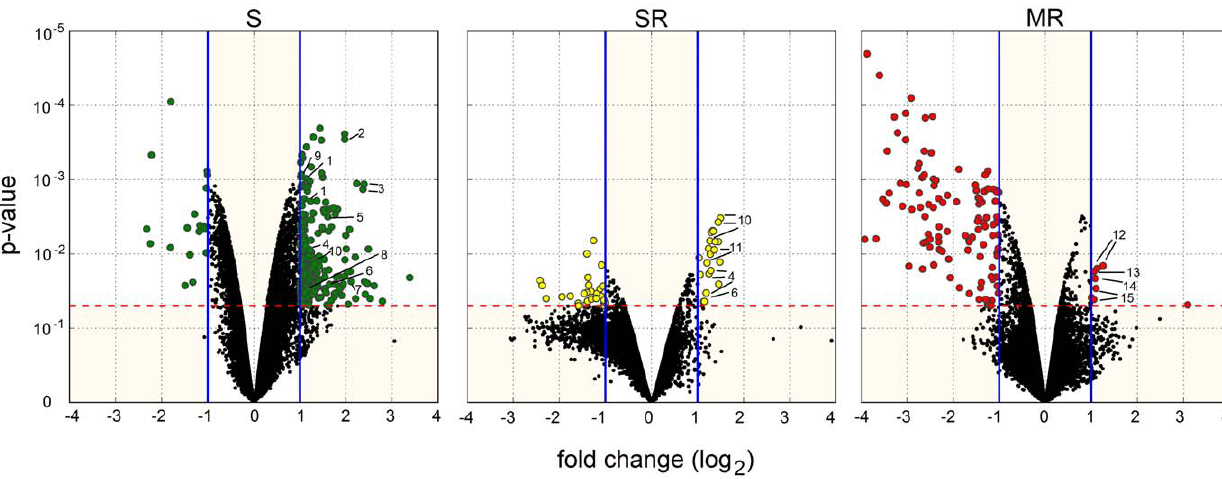
Figure 1. Transcriptional responses in three Myzuspersicae genotypes (S, SR and MR) subjected to a pirimicarb. Volcano plots for each genotype show the log 2 fold change (x axis) and the statistical significance ( y axis) between the controls and treatments. Vertical lines indicate 2-fold expression difference in either direction ( 2 1 . log2FC . 1). Horizontal line indicates significance threshold (P , 0.05). Statistical analysis is based on a Bayesian inference using a lineal model, and reflects both biological and technical replications. Genes showing both 2-fold differential expression and a significant P value are colored. Not all labels appear in the S, SR and MR volcano plot in order to preserve readability (see Table 2 and supporting material for a full listing of significantly over-expressed genes). Gene abbreviations: 1, glutathione s-transferase ; 2, cytochrome p450 family CYP6CYP3 ; 3, carboxylesterase type FE4 ; 4, cathepsin b ; 5, cytochrome p450 family CYP6 ; 6, cuticle protein ; 7, salivary peptide ; 8, ABC transporter ; 9, glucose transporter ; 10, cytochrome p450 ; 11, heat shock protein 70 ; 12, heterotrimeric guanine nucleotide-binding protein ; 13, histone h3 methyltransferase , 14, eukaryotic initiation factor ; 15, unknown protein .